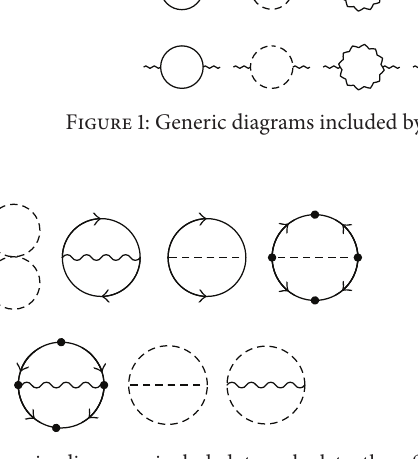
Figure 2: Generic diagrams included to calculate the effective potential at the two-loop level. These are the diagrams which do not vanish in the gaugeless